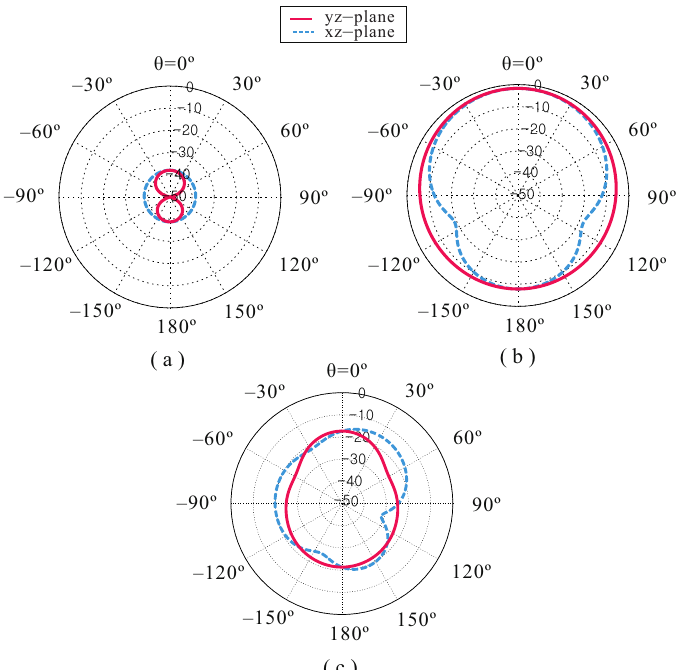
Figure 9. Simulated radiation pattern of the proposed antenna in the xz and yz − planes: ( a ) 14 MHz; ( b ) 200 MHz; ( c ) 370 MHz.